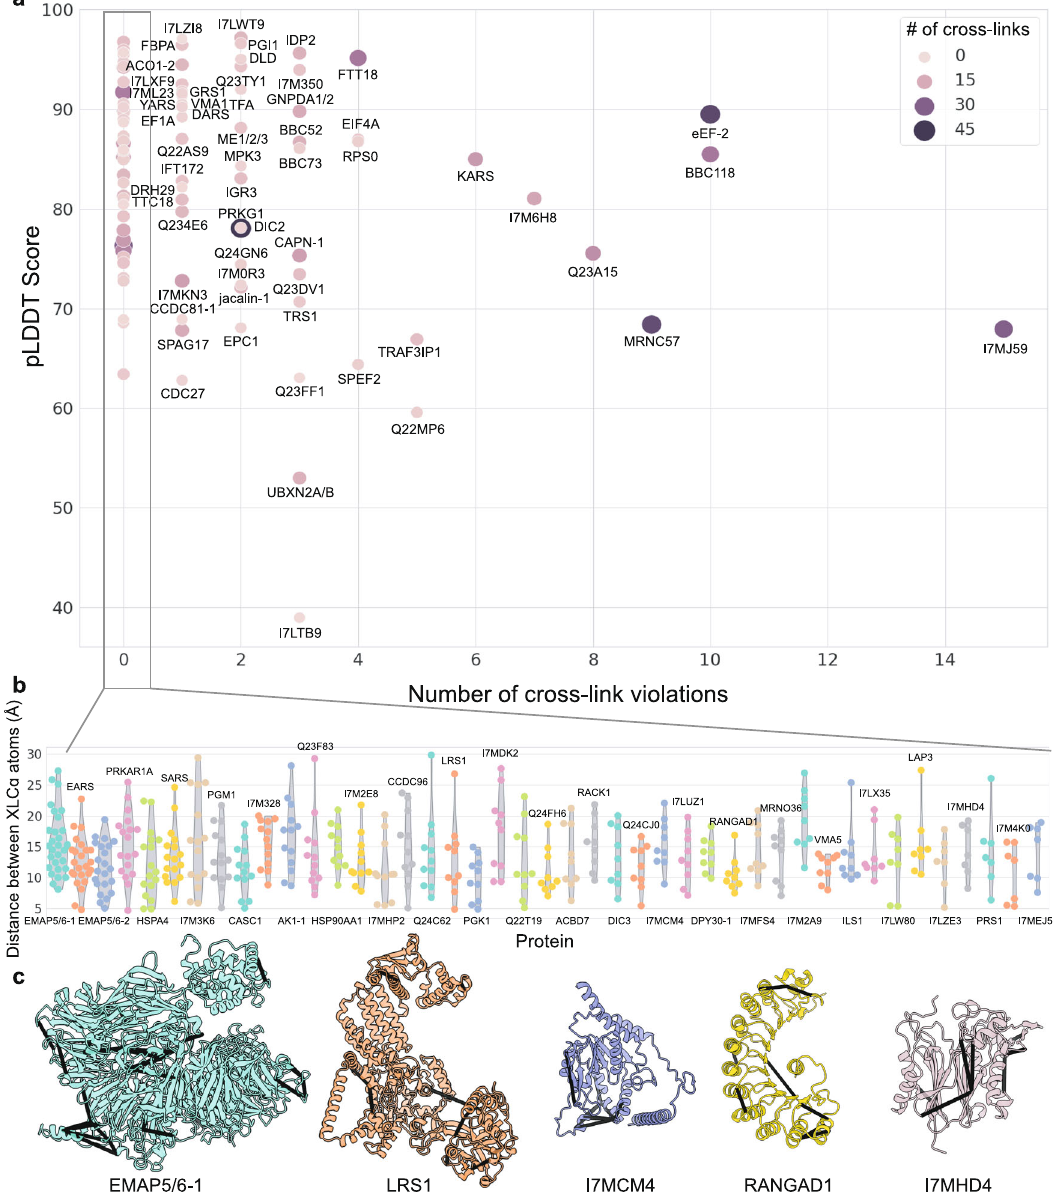
Fig. 3 A general trend for fewer cross-link violations in AlphaFold2 models with higher pLDDT scores. a Number of cross-link violations plotted against the pLDDT score for each of the T. thermophila proteins predicted. The size and shade of each dot represent the number of intramolecular cross-links for a given protein. The full data are provided as Supplementary Table S2. b A distance distribution view of the 43 proteins with no cross-link violations. c A selection of proteins from ( b ) with cross-links mapped onto the AF2-predicted